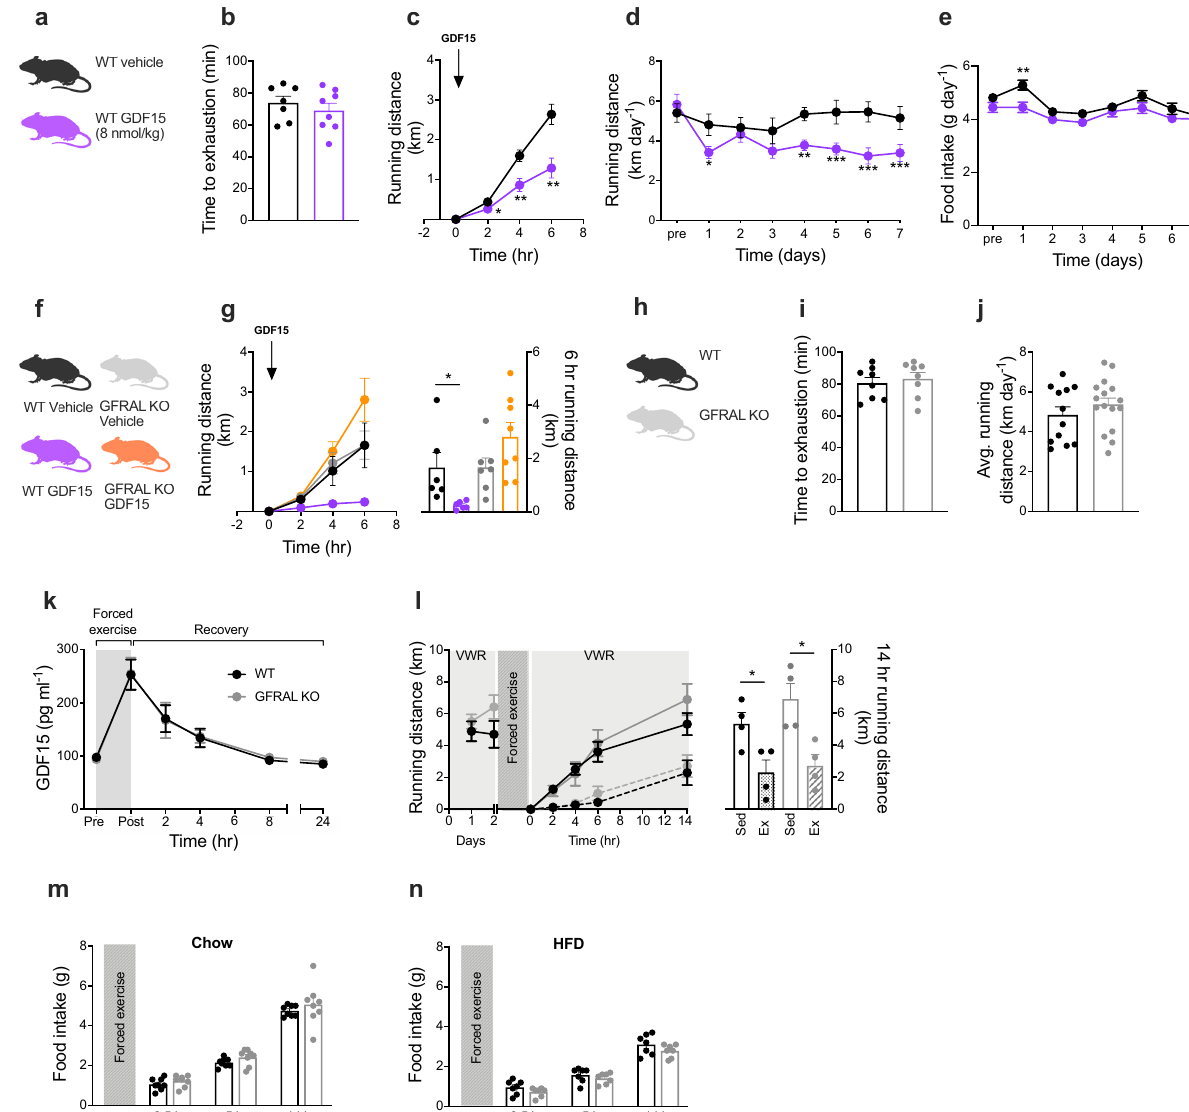
Fig. 3 Effects of pharmacological GDF15 and exercise-induced GDF15 on food intake and running behavior. a, b Effect of single subcutaneous injection of rhGDF15 (8 nmol/kg bw, n = 8) or vehicle ( n = 7) on forced treadmill running until exhaustion in mice. c Effect of single subcutaneous injection of rhGDF15 (8 nmol/kg bw, n = 16) or vehicle ( n = 16) administered at the onset of the dark cycle on voluntary wheel running distance (2 h, p = 0.0210; 4 h, p = 0.0075; 6 h, p = 0.0036). d, e Effect of daily subcutaneous injections (at the onset of the dark cycle) of rhGDF15 (8 nmol/kg bw, n = 14) or vehicle ( n = 14) on voluntary wheel running (day 1, p = 0.0140; day 4, p = 0.0042; day 5, p < 0.001; day 6, p < 0.001; day 7, p < 0.001) and food intake (day 1, p = 0.0032). f , g Effect of single subcutaneous injection of rhGDF15 (8 nmol/kg bw) or vehicle on voluntary wheel running in WT (vehicle n = 6; rhGDF15 n = 6, p = 0.0308) and GFRAL KO (vehicle n = 7; rhGDF15 n = 8) mice. h, i Forced treadmill running to exhaustion in WT ( n = 8) and GFRAL KO ( n = 8) mice. j Voluntary wheel running distance in WT ( n = 12) and GFRAL KO ( n = 16) mice k Plasma GDF15 values were measured after forced exercise to exhaustion on treadmill in WT ( n = 13) and GFRAL KO ( n = 11) mice. l Effect of forced exhaustive treadmill exercise on voluntary wheel running (VWR) in WT ( n = 4 sedentary vs. n = 4 forced exercise, p = 0.0261) and GFRAL KO ( n = 4 sedentary vs. n = 4 forced exercise, p = 0.0134) mice. m Effect of forced exhaustive treadmill exercise on chow in WT ( n = 8) and GFRAL KO ( n = 8) mice, and n HFD intake in WT ( n = 7) and GFRAL KO ( n = 7) mice. Data are presented as mean ± SEM, * P < 0.05; ** P < 0.01; *** P < 0.001. b, g, i, j, l, m, n Two-tailed unpaired t test. c , d , e , k , Repeated measures two-way ANOVA with Bonferroni multiple comparisons test. Source data are provided as a Source Data fi